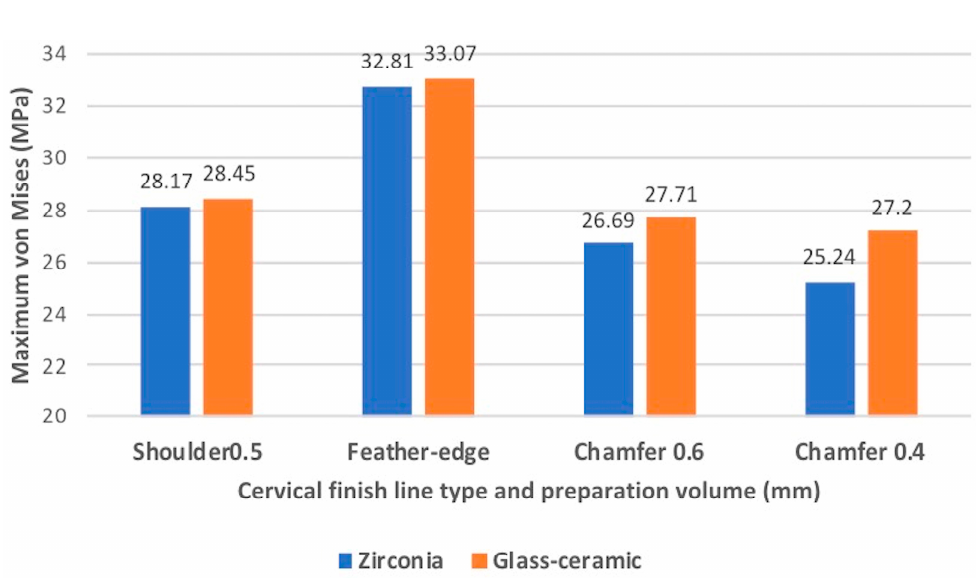
Figure 4. Comparison of the maximum EQVs of the all-ceramic crowns with four types of cervical finish lines under a vertical load of 200 N. The highest value occurred on the feather-edged type.